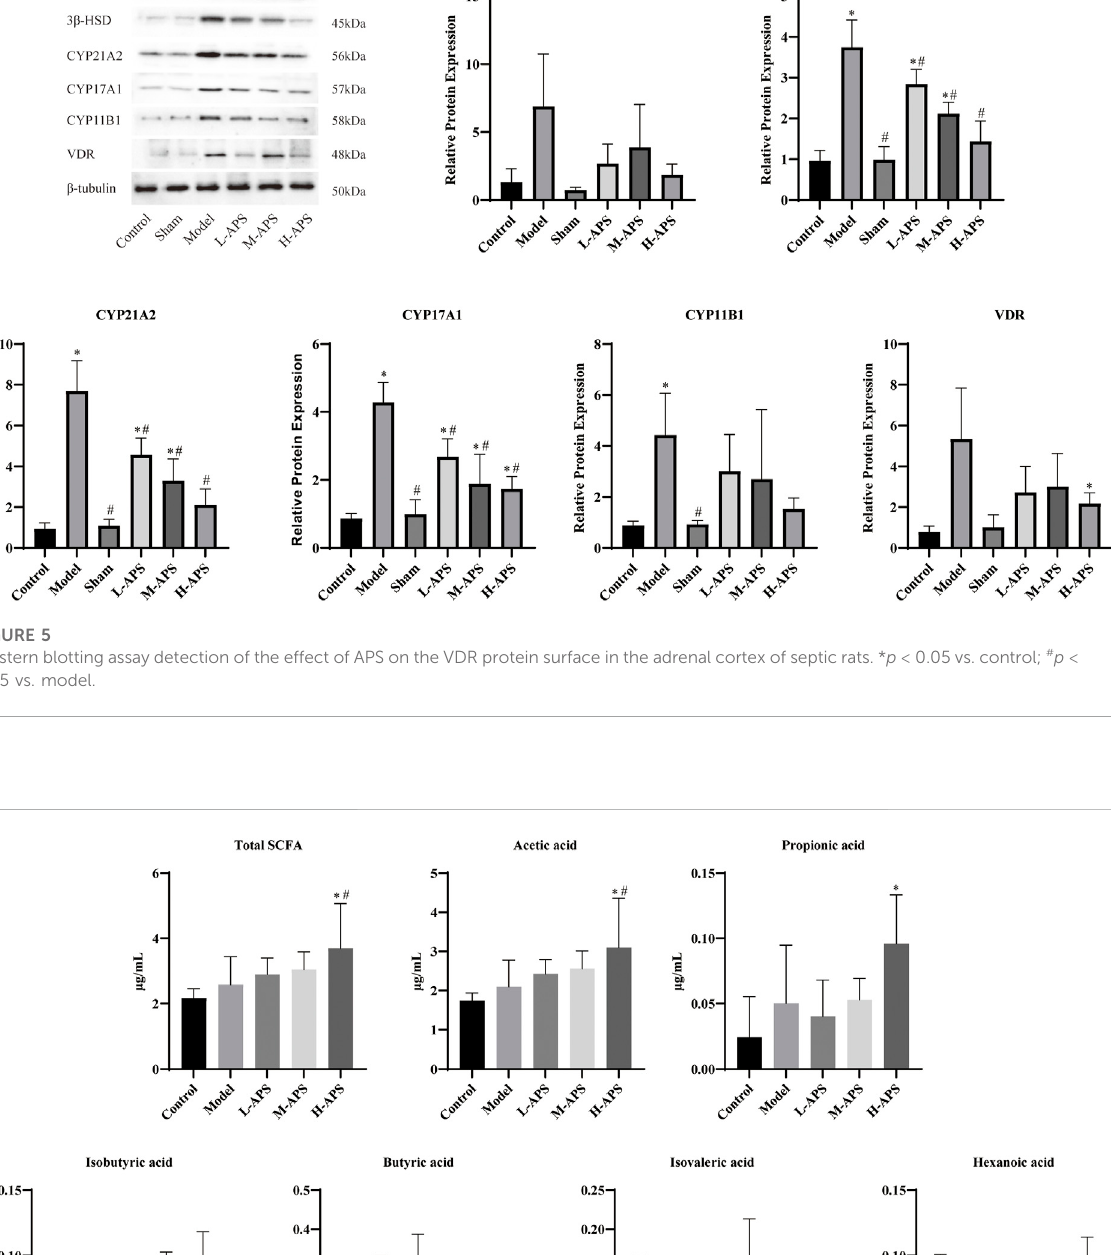
Frontiers in Bioengineering and